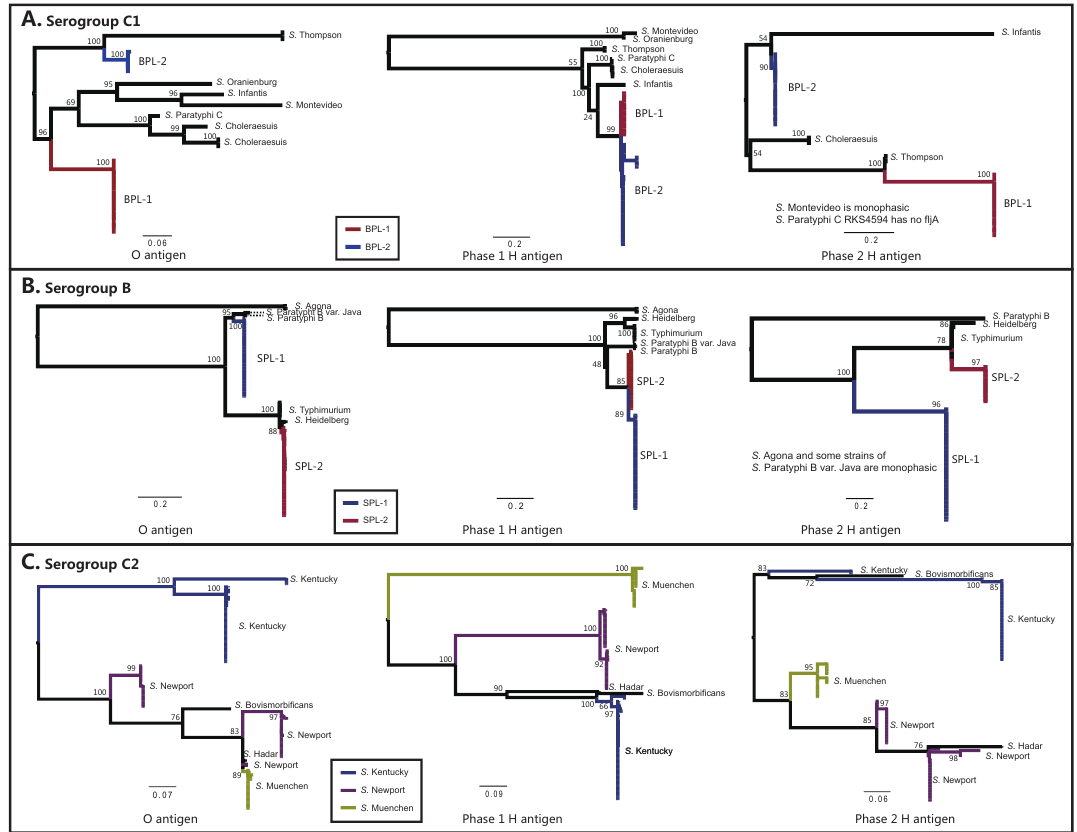
Figure 6. Phylogenetic analysis of O-, H1- and H2-antigens. Maximum-likelihood trees based on the nucleotide sequences of core genes in O-, H1- and H2-antigen clusters of the strains belong to serogroup C1 ( A ), B ( B ), and C2 ( C ), drawn using MEGA 7 software with GTR model. The primary node values of the tree are the bootstrap values (100 replicates). The genes used for the analysis were listed in Table